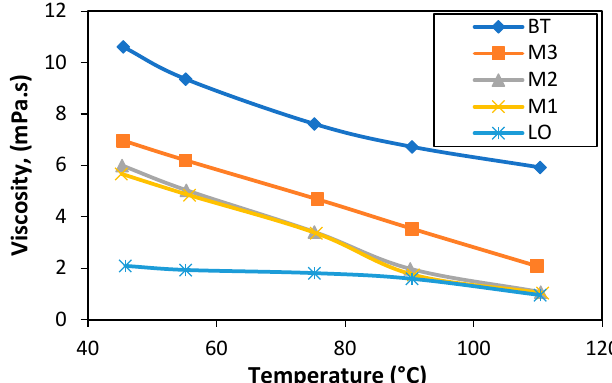
Figure 5. Influence of temperature on the viscosity of the crude oils and their mixtures .